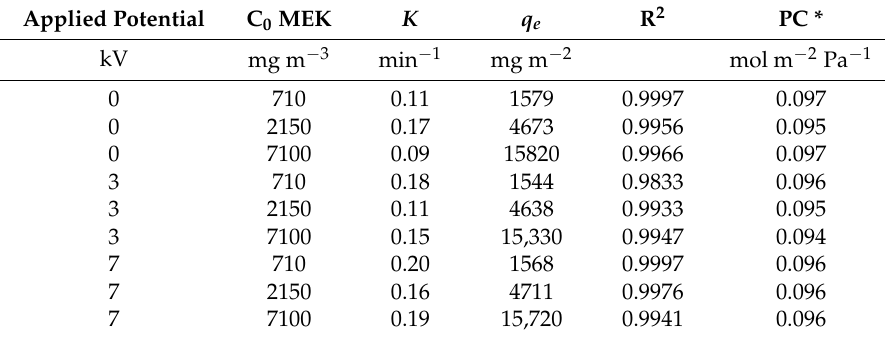
Table 5. Results of the experimental batch adsorption kinetic data fitting.